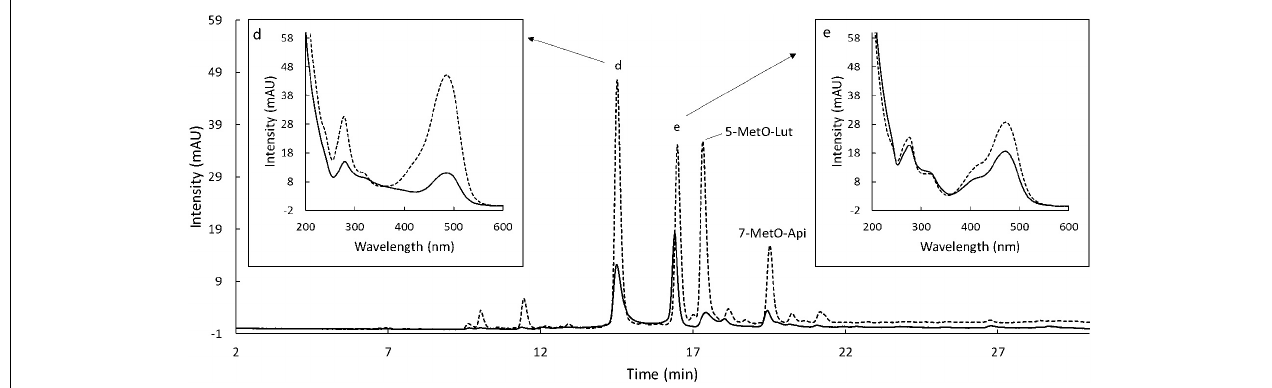
FIGURE 4 | High-performance liquid chromatograph (HPLC) chromatogram of flavonoids extracted from Armorik with acetone 70% (solid line) and with hydrochloric (HCl)/MetOH (dash line) recorded at 480 nm. d: luteolinidin-chloride, e: apigenidin-chloride; f: naringenin, and g: apigenin. In addition, the UV spectra of peak d (left) and e (left), corresponding to the samples extracted with acetone 70% (solid line) and with HCl/MetOH (dash line).